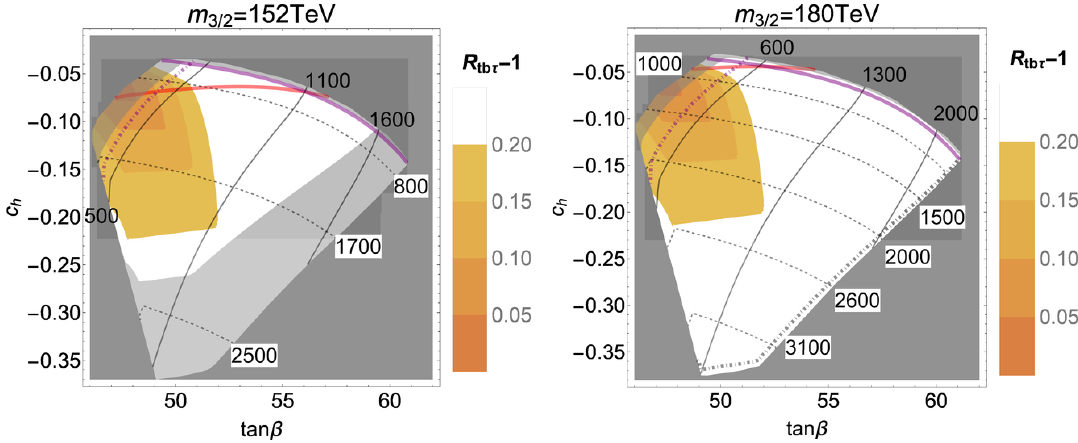
Figure 6 . Contours of R tb(cid:28) (cid:0) 1 for m = 152 TeV (left) and 180 TeV (right). The black solid 3 = 2 (dashed) line represents the mass of the right (left)-handed selectron in units of